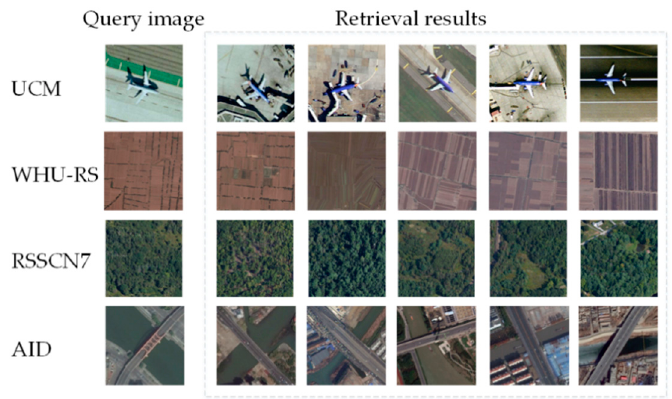
Figure 11. Top five image retrieval results.